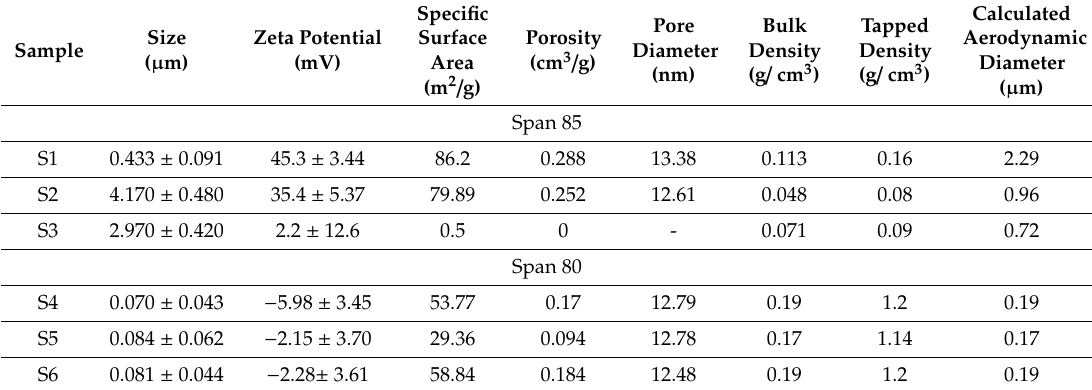
Table 2. Physical characterization of the prepared microparticles.